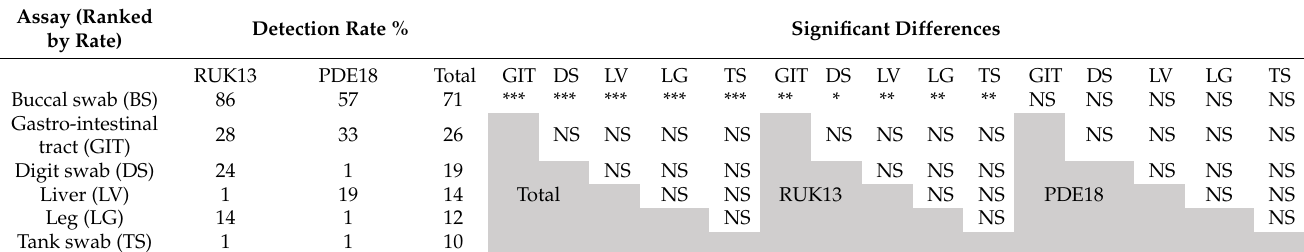
Table 4. Sample types ranked by detection rate (%) with significant differences of pairwise compar- isons between sample types illustrated overall and by virus type.